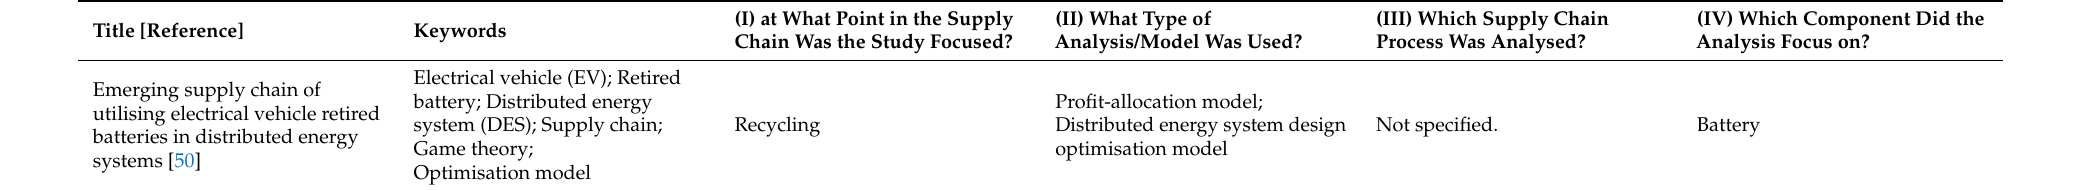
Table A5. PRISMA meta-analysis of documents found related to electric vehicles supply chains.